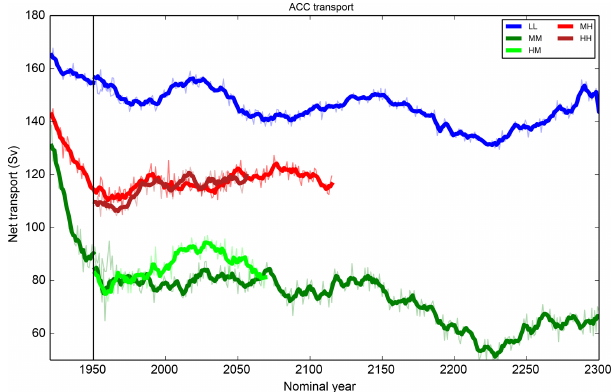
Figure 18. Time series of the Antarctic Circumpolar Current (ACC) transport calculated between Antarctica and South America across Drake Passage for spinup-1950 and control-1950